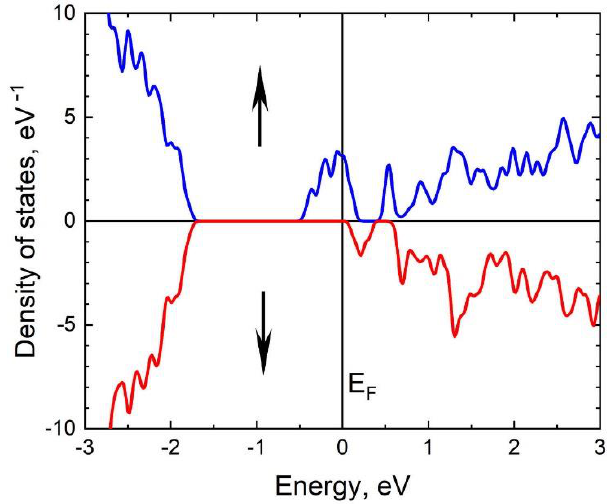
Figure 14. Density of spin-up and spin-down electronic states for system II with n C blue curve in the upper half describes the spin-up electrons, the red curve in the lower half describes the spin-down electron. The system is a half-metallic ferromagnet with 100% spin polarization.